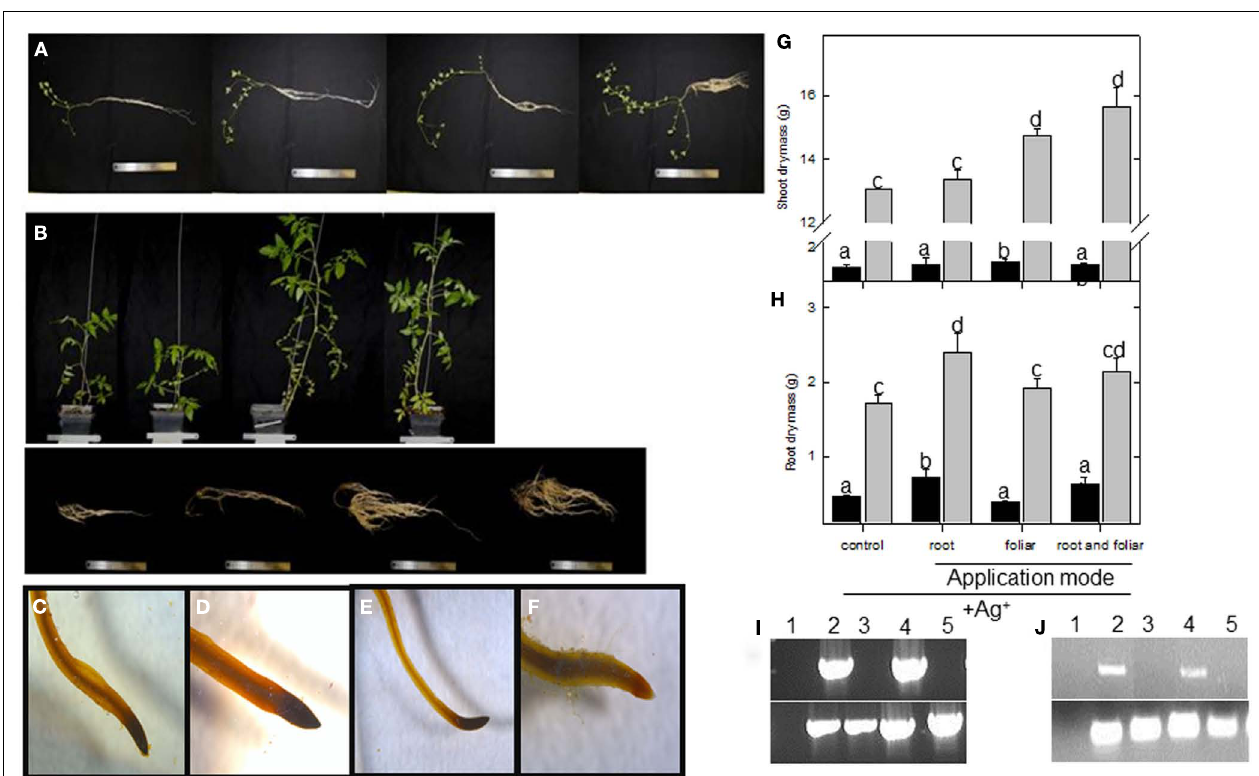
FIGUREA1 | Physiological assessment of lumichrome treatment on lotus and tomato plants. Phenotypes of control, 5nM lumichrome root-drenched, foliar, and a combination of root and foliar applications (from left to right) of (A) lotus plants and (B) tomato shoots (top) and roots (bottom) grown under a 16-h photoperiod. Lugol staining of mature lateral root tips of (C) control and (D) lumichrome-treated lotus roots, and (E) control and (F) lumichrome-treated tomato roots. (G) Shoot and (H) root dry mass was recorded upon a weekly 10 μ M AgNO 3 treatment in parallel with untreated controls (see Figure 1 ) for